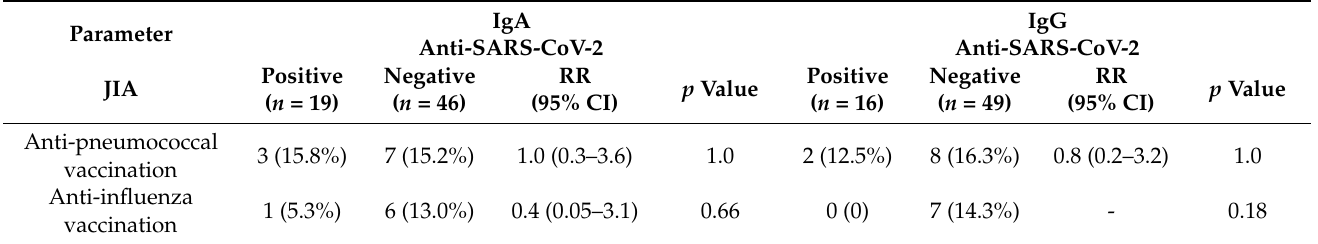
Table 6. The prevalence of seropositivity in JIA patients depending on earlier vaccinations: anti- pneumococcal and